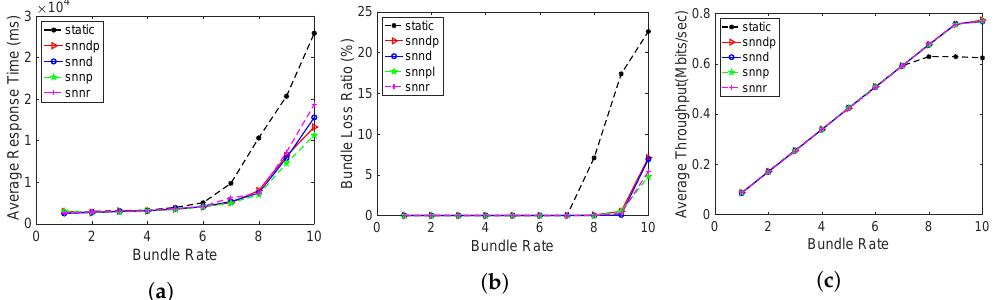
Figure 11. Routing performance: Scenario 5. ( a ) Average response time; ( b ) Packet loss ratio (%); ( c )